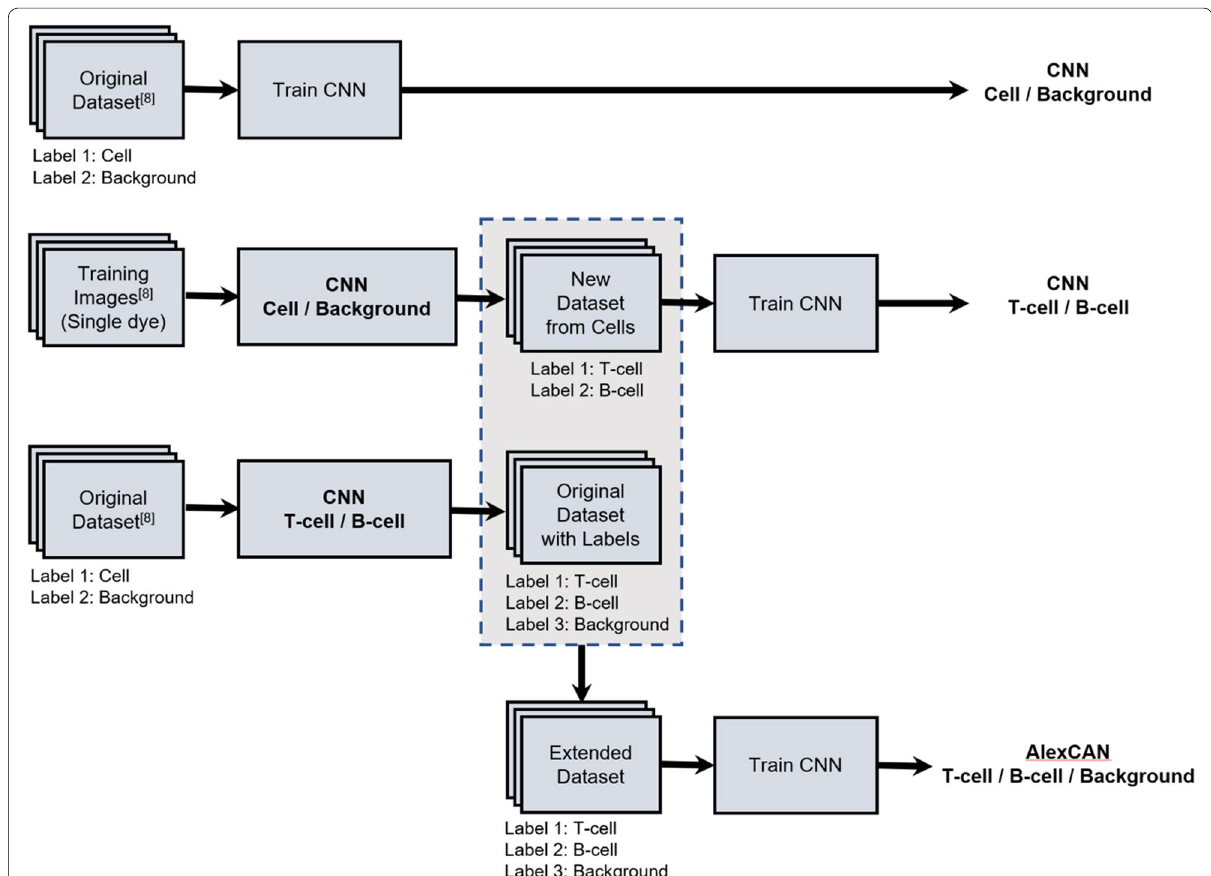
Fig. 2 Flow chart of training AlexCAN. Firstly, a CNN < Cell/Background > is re-trained using the original dataset with the labels of cell and background. Then, training images dyed with a single dye are exhaustively searched, and the trained CNN < Cell/Background > is used to create a new dataset with labels T-cell and B-cell. After that, another CNN < T-cell/B-cell > is trained from the newly created dataset, which can distinguish T-cells from B-cells. Then, cells in the original dataset are annotated by using the newly trained CNN < T-cell/B-cell >. We obtain the extended dataset by merging the newly created dataset and annotated original dataset. Lastly, AlexCAN is re-trained from the extended dataset as our final classifier, that can separate cells from background and can also annotate them as T-cell and